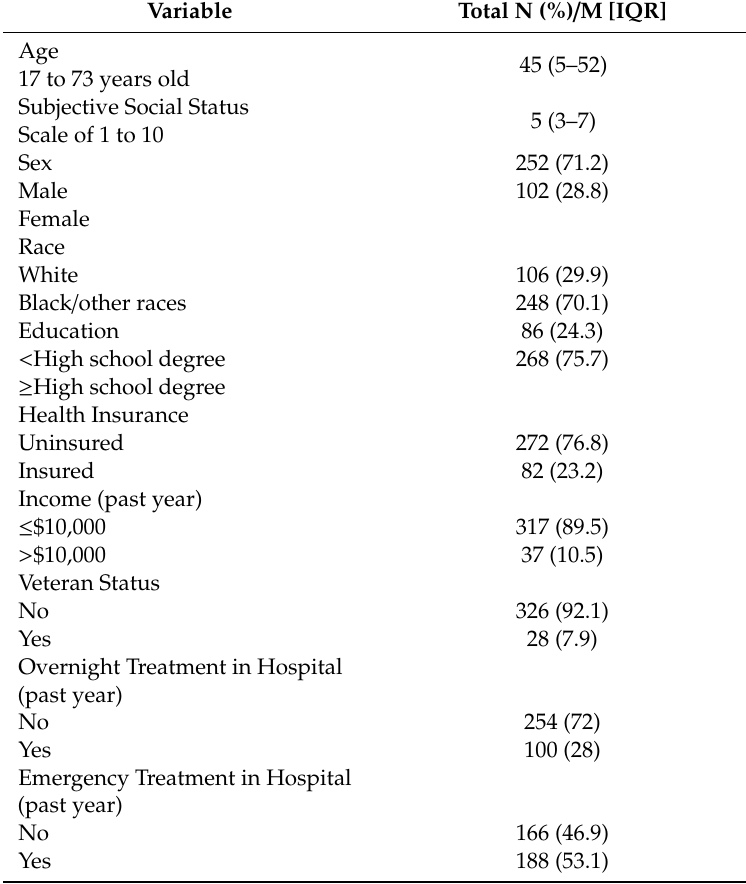
Table 1. Participant Characteristics among a Sample of Homeless Adults (N =